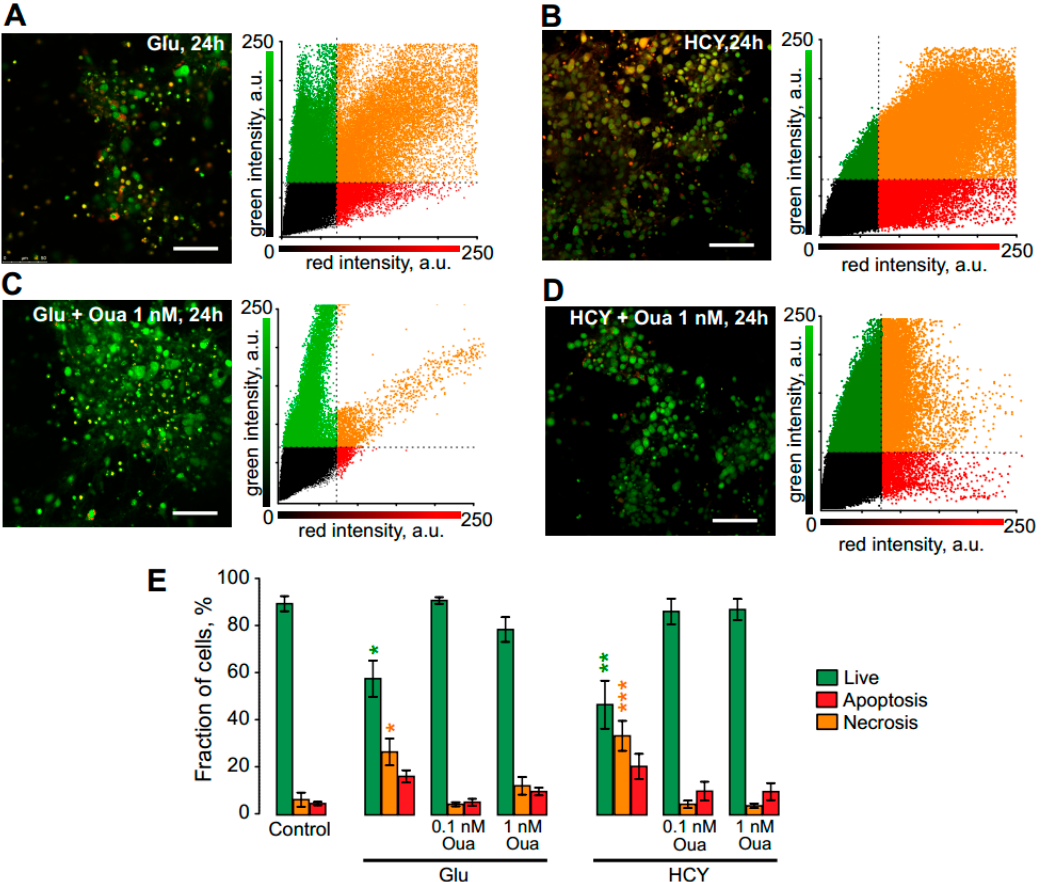
Figure 5. Ouabain prevents the neurotoxicity induced by 24 h excitotoxic insult in rat cortical neurons. ( A ) Confocal image after 24 h treatment with 100 μ M Glu + 30 μ M glycine (Glu) and ( B ) with 100 μ M HCY + 30 μ M glycine (HCY); ( C , D ) addition of 1 nM ouabain. Scale bar, 100 μ m. Data obtained from the control and that after treated with 100 μ M Glu or 100 μ M HCY and either 0.1 nM or 1 nM Oua. The correlation plots shown on the right of corresponding images allow estimation of the cell viability (percentages of live, necrotic, and apoptotic neurons). ( E ) Data obtained from the control and that after treatment with 100 μ M Glu or 100 μ M HCY and either 0.1 nM or 1 nM Oua. Green columns: percentages of live. Red: necrotic. Orange: apoptotic neurons. Data are expressed as mean ± SEM. * p = 0.03; ** p = 0.002; *** p = 0.0008, respectively, are significantly different from the control, one-way ANOVA with Tukey’s post- hoc test). Table 2. The neuroprotective effect of ouabain against neurotoxicity induced by 24 h glutamate (Glu) or homocysteine (HCY) treatment of rat cortical neurons. Ouabain Live, Ouabain